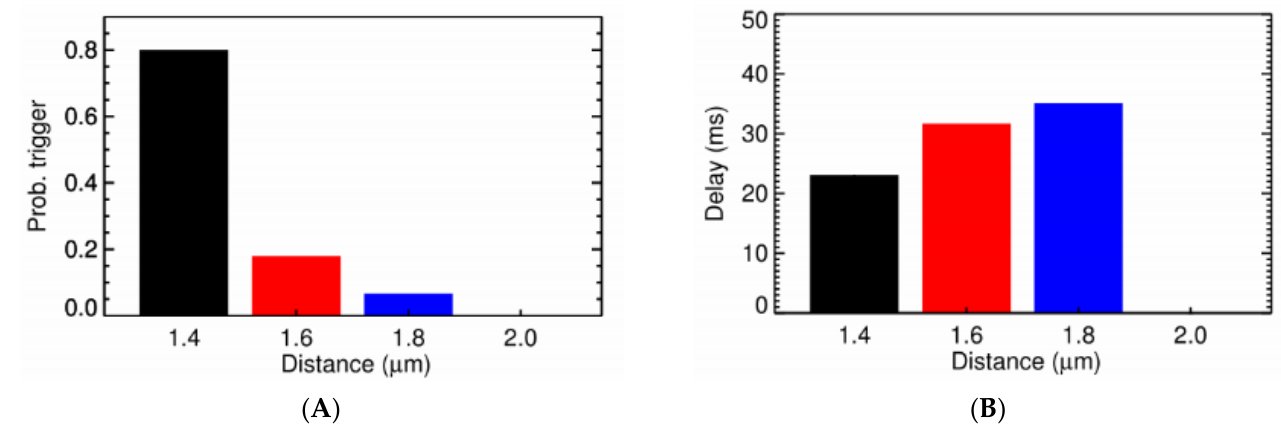
Figure 10. (A) The P o,trigger of Ca 2+ release from 9 activated CRUs on one Z-line on the CRU at different distances. ( B ) The time delay for the activation at different distances.